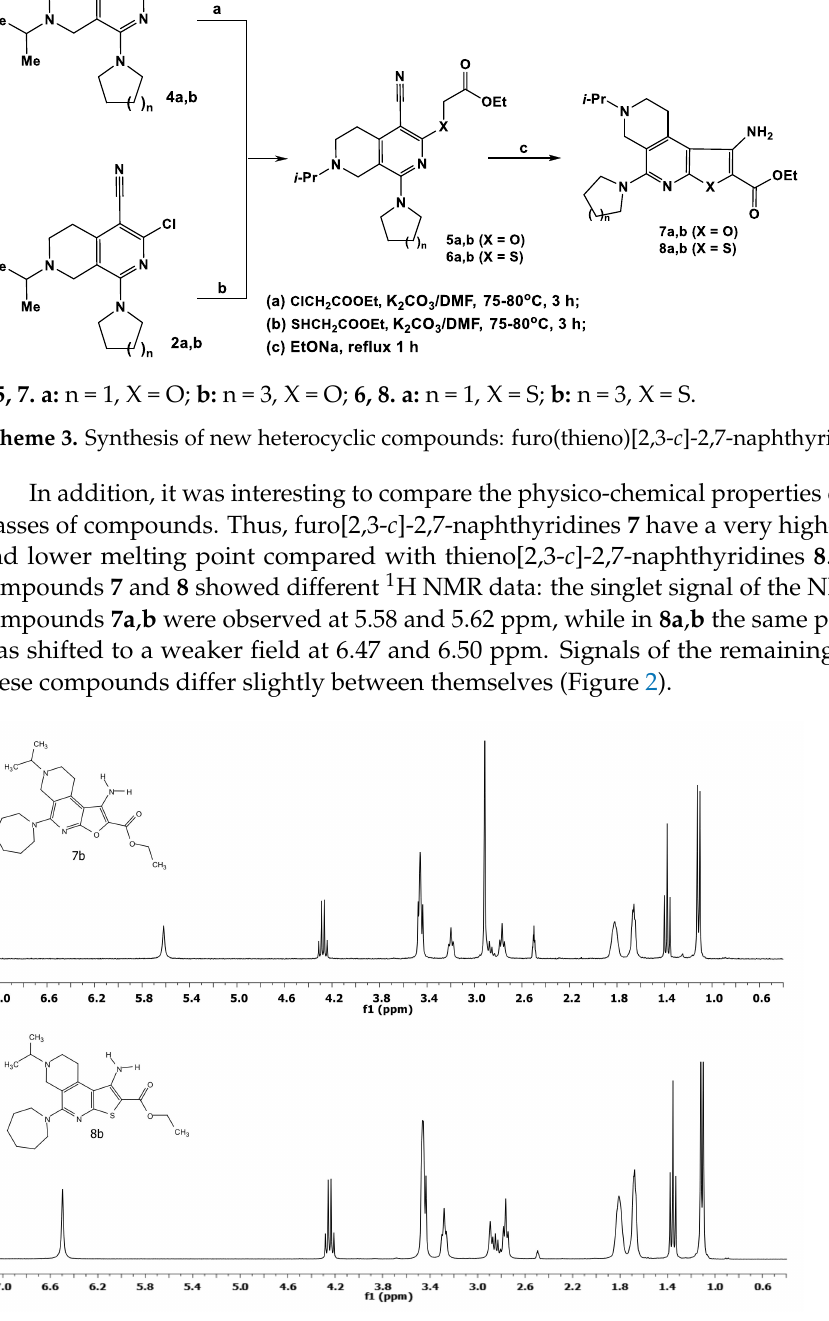
Figure 2. 1 H NMR spectra of compounds 7b and 8b